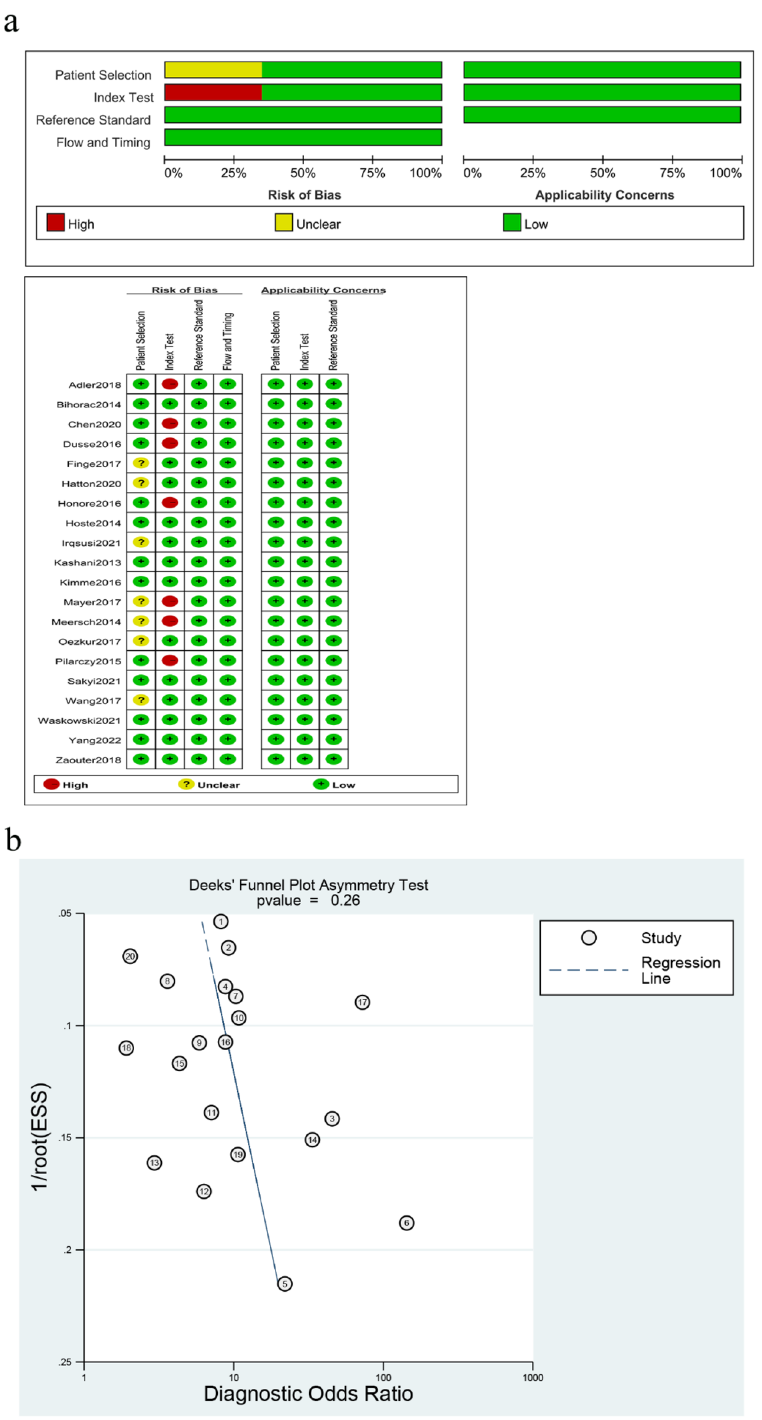
Figure 2. ( a ) Summary of the methodological quality of the studies. ‘−’ in red and ‘+’ in green mean high risk and low risk, respectively. ‘?’ in yellow means unclear risk. ( b ) Deek funnel plot asymmetry test for publication